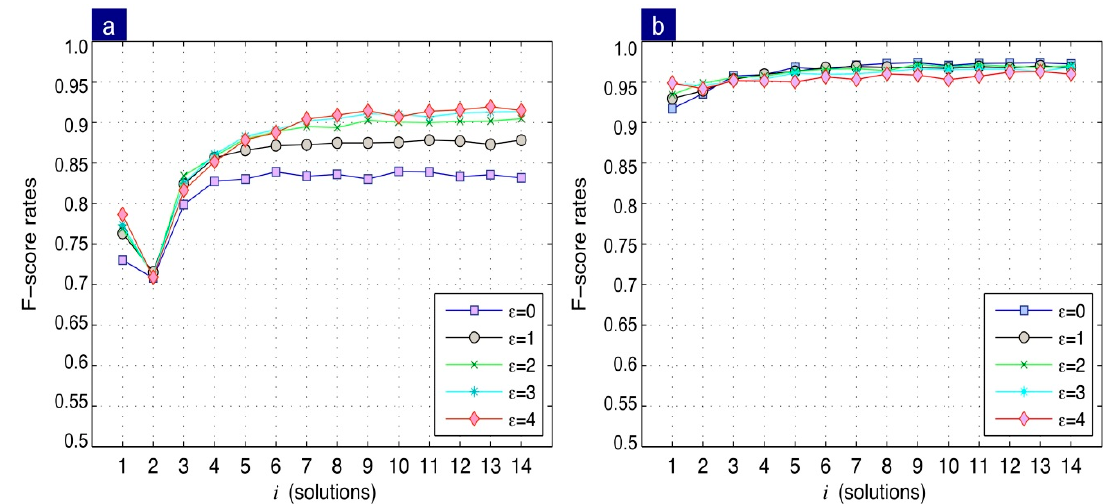
Figure 13. Performance of the proposed method as a function of the i and different values of ε : ( a ) two and ( b ) three views.